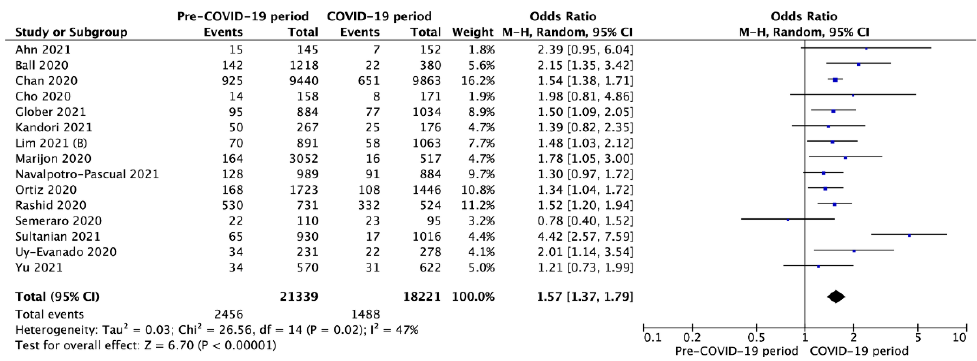
Figure 6. Forest plot of survival to hospital discharge in pre- vs. intra-COVID-19 periods. The center of each square represents the weighted odds ratios for individual trials, and the corresponding horizontal line stands for a 95% confidence interval. The diamonds represent pooled results. Legend: CI = confidence interval; OD = odds ratio.